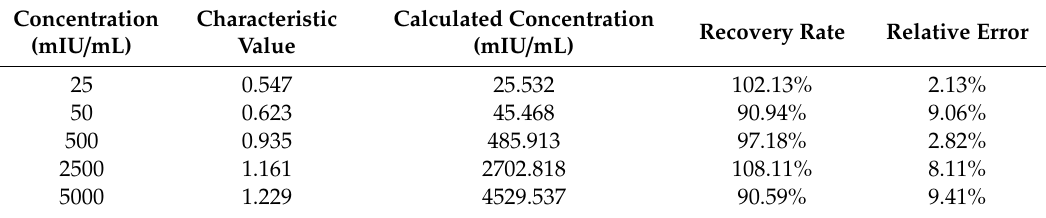
Table 1. Test results for HCG.